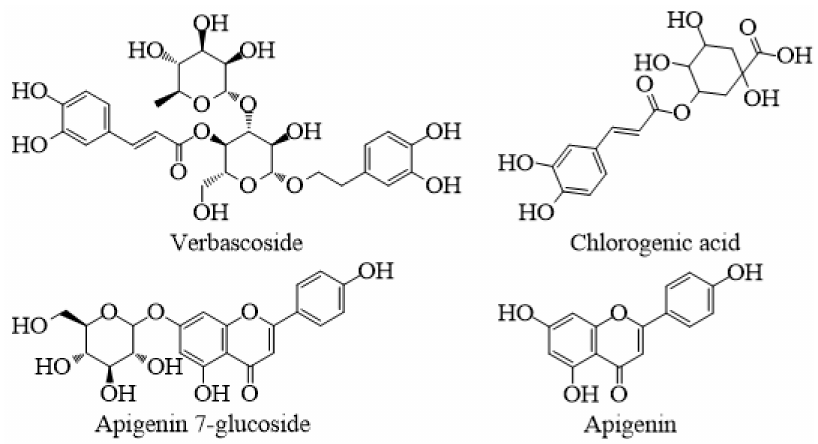
Figure 1. Major phenolic compounds identified in S. cretica ssp. anatolica extracts. Chlorogenic acid, the most abundant phenolic in the studied extracts, has been de- tected in all of the aforementioned and previously studied Stachys species, both methanol and aqueous extracts [13,15,18–22]. The range of the chlorogenic acid in mentioned methanol extracts was from 95.55 µ g/g to 35,372 µ g/g, while in aqueous extracts range from 426.30 µ g/g to 17,772 µ g/g. In all the previously studied Stachys species,